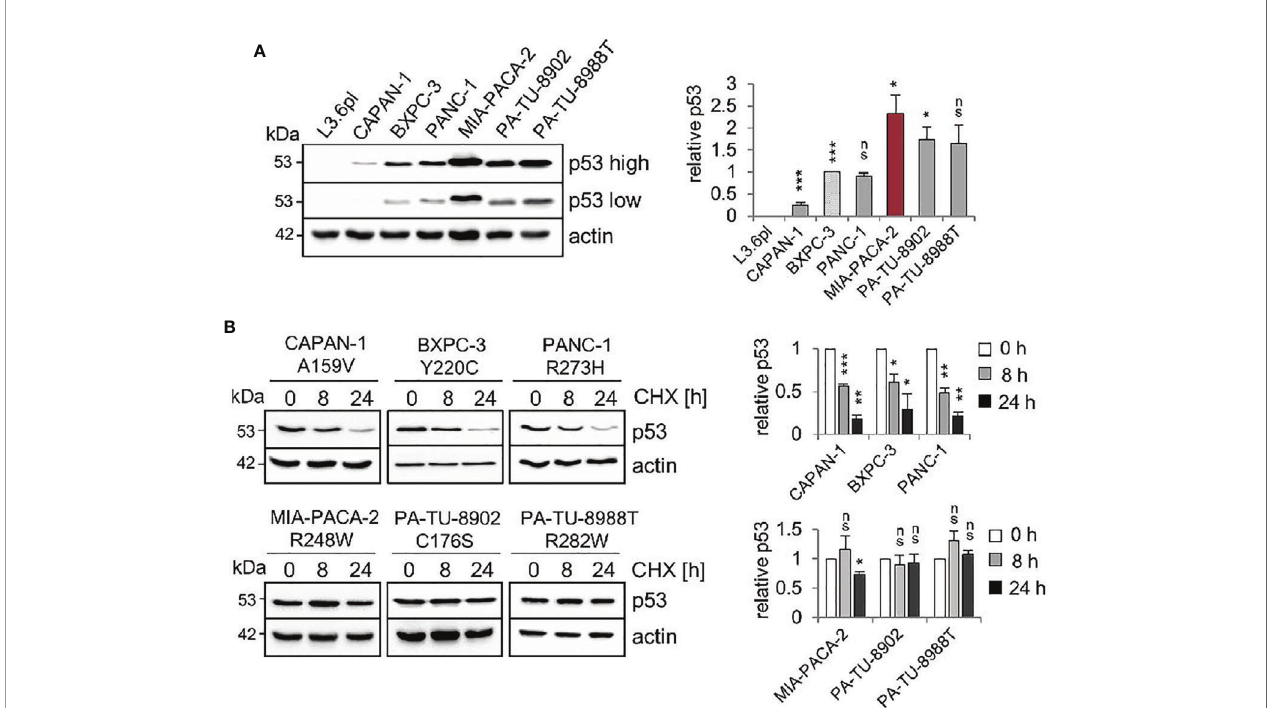
FIGURE 1 | Stabilization of various missense p53 mutants in human PDAC cell lines. (A) Six PDAC cell lines harboring various missense mutant p53 variants exhibit differential steady state protein levels. One representative immunoblot analysis out of four is shown. Actin as loading control. ‘ p53 high ’ and ‘ p53 low ’ mean exposure time. CAPAN-1 (mutp53 A159V ), BXPC-3 (mutp53 Y220C ), PANC-1 (mutp53 R273H ), MIA-PACA-2 (mutp53 R248W ), PA-TU-8902 (mutp53 C176S ) and PA-TU-8988T (mutp53 R282W ). L3.6pl cells harboring a truncating LOF mutation served as p53 null control. (right) Diagrams represent the means ± SEM of densitometric quanti fi cations of two independent experiments with two technical replicates each (total n = 4 immunoblots), normalized to actin or HSC70 and calculated relative to mutp53 level in BXPC-3 cells (patterned bar). (B) Differential half-lives of mutp53 proteins. Cycloheximide (CHX) chase experiment. Cells were treated with CHX for 8 and 24 h or vehicle control (0 h). One representative immunoblot. Actin, loading control. (right) Diagrams represent mutp53 protein levels as means ± SEM of densitometric quanti fi cations of two independent experiments (n = 2), normalized to actin or HSC70. Calculated relative to control treatment (0 h). (A, B) Student ’